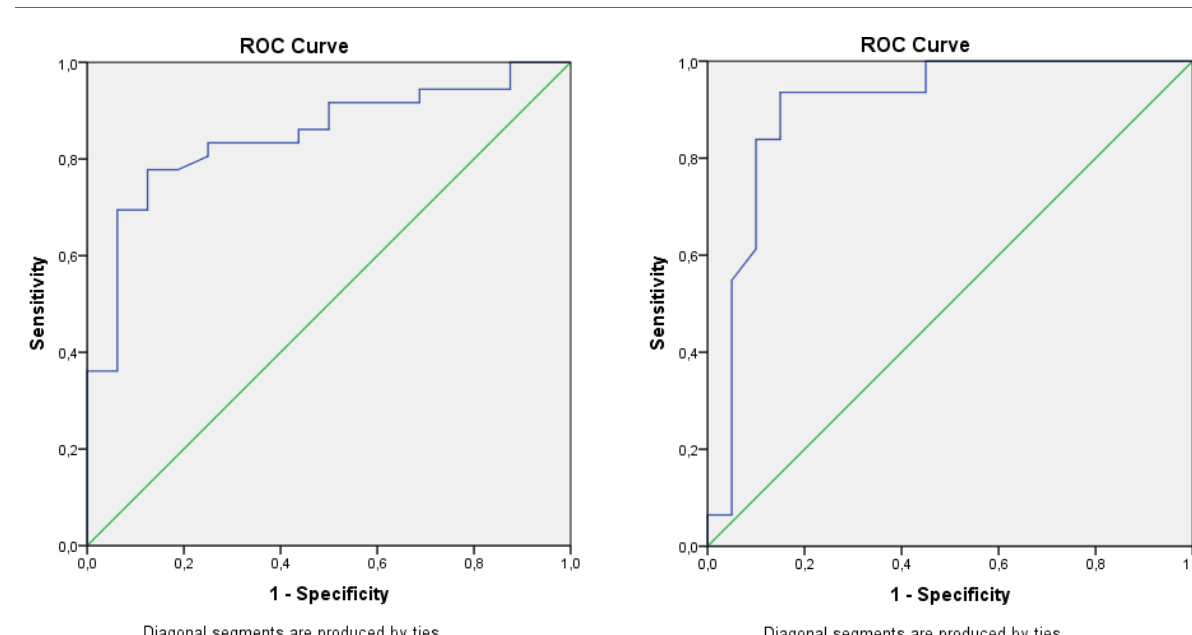
Fig. 2. ROC analysis of the pNfL of patients with and without NEDA-3 status. The sensitivity and specificity of the predictive model were 77.8% and 87.5%, respectively, with a cut-off level of 9.1 pg/mL for pNfL, and an area under curve (AUC) of 0.848 (95% CI: 0.739–0.957; P <0.001). Lower pNfL values indicate stronger evidence for the presence of NEDA-3 status.